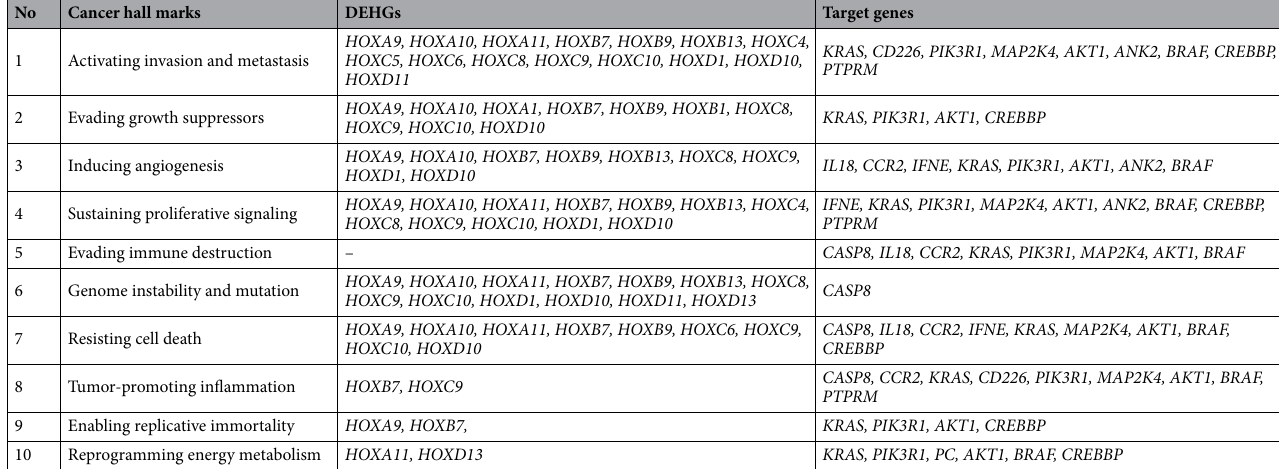
Table 2. Differentially expressed HOX genes and their target genes associated with the development of cancer